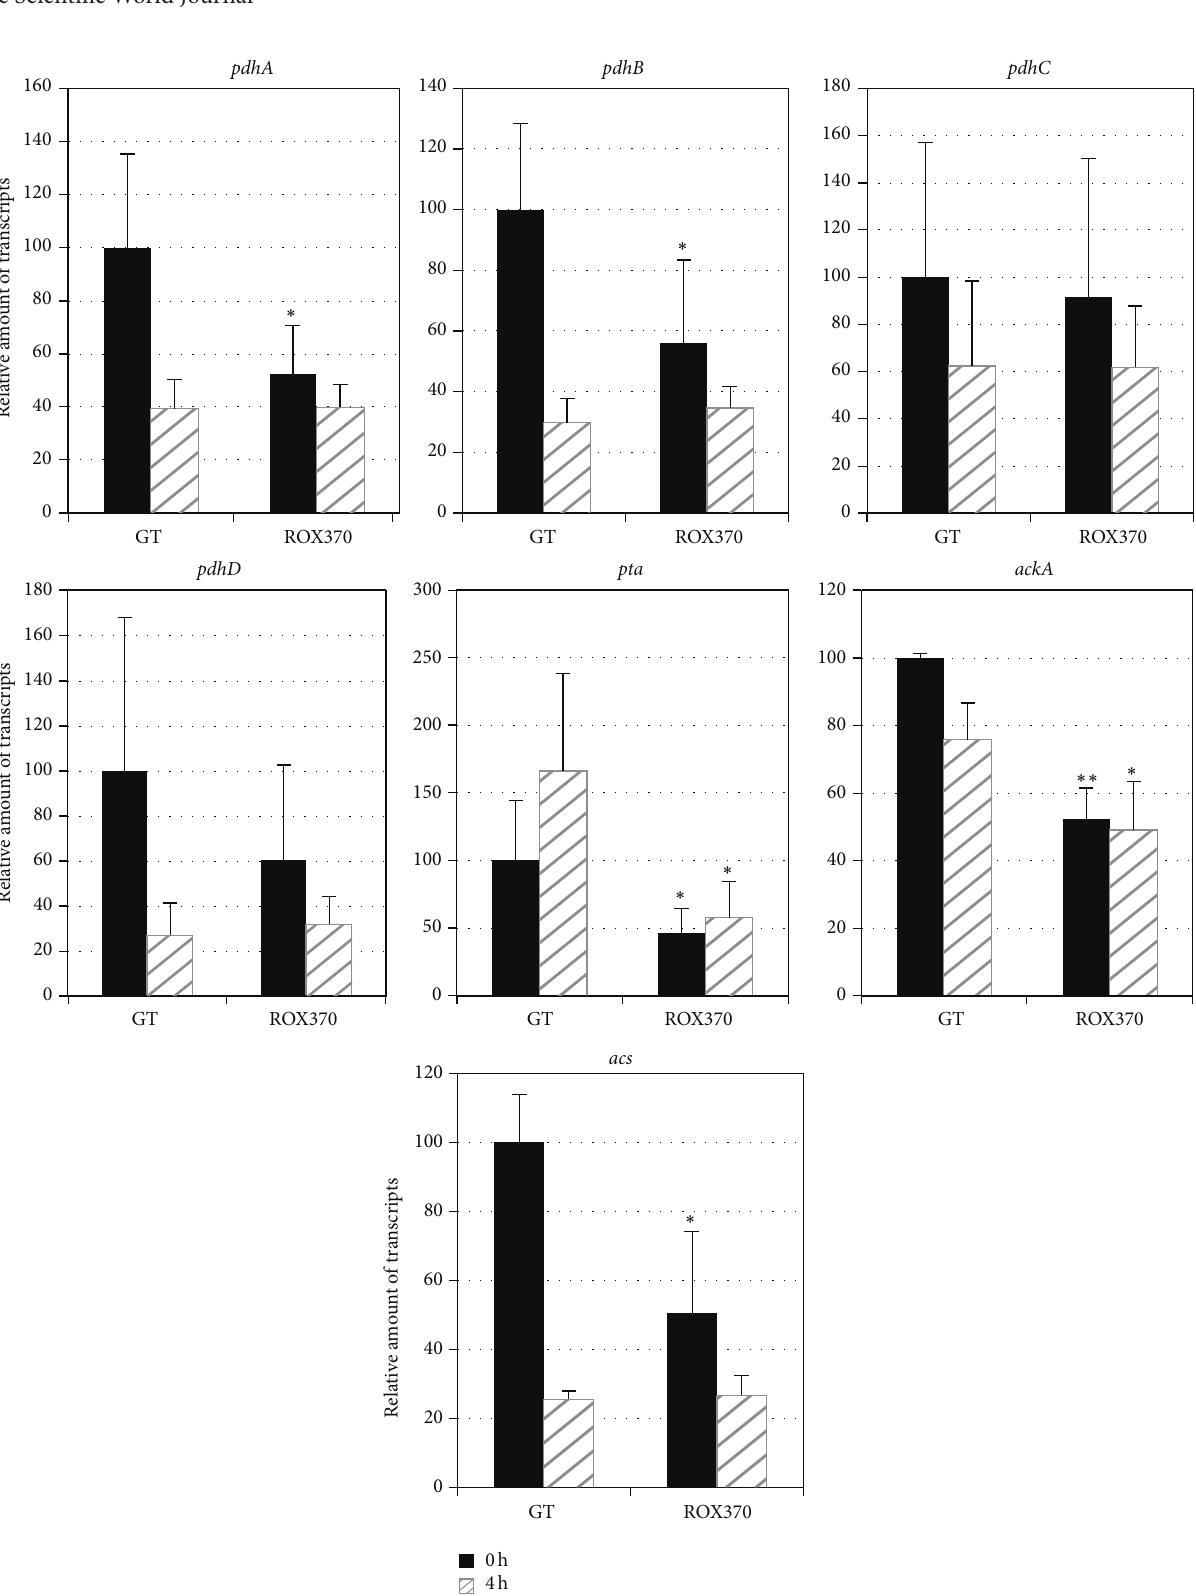
Figure 4: Quantitative real-time PCR analysis of transcription in GT and ROX370. Relative transcript levels of 7 genes involved in pyruvate metabolism ( pdhA , pdhB , pdhC , pdhC , pta , ackA , and acs ) are shown. Data represent the mean ± SD from four independent experiments. Transcript levels were calibrated relative to that of corresponding levels in GT under nitrogen-replete conditions (set at 100%). Asterisks indicate statistically significant differences between GT and ROX370 (Student’s 𝑡 -test; ∗ 𝑃 < 0.05 , ∗∗ 𝑃 < 0.005